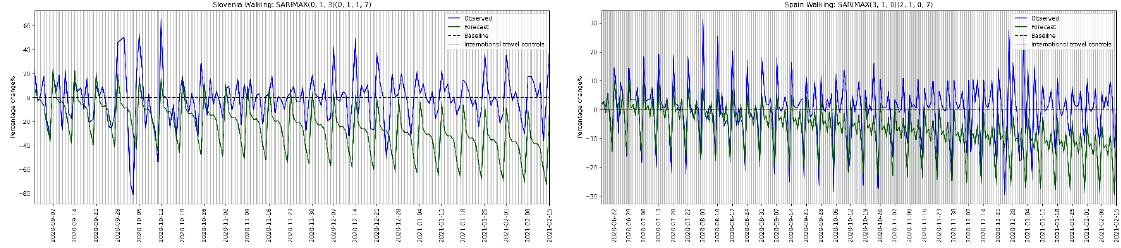
Figure 12. SARIMAX forecasts for walking in relation to International travel controls (a: Croatia, b: Poland, c: Portugal, d: Slovakia, e: Slovenia, f: Spain) The visual inspection of the difference between the observations and the forecasted values, namely the residuals, is important in order to ensure a no bias in the forecasting method (Hyndman and Athanasopoulos, 2018). In Figure 13, the diagnostics plot of the residuals from the SARIMAX model for walking in relation to school closing in Austria is presented as an example, with a standardized over time residuals plot, a histogram plus estimated density of standardized residuals, along with the normal density plotted, a normal Q-Q plot, with the normal reference line and a Correlogram (Seabold and Perktold, 2010). The top left plot shows no significant correlation in the residuals series, while the mean value is close to zero. In addition, this time plot does not display any obvious seasonality and appear to be white noise. The histogram on the top left plot suggests normal residuals, as the orange line follows closely the normal distribution. A normal indication of the residuals is also provided from the qq- plot, in which the residual distribution follows the linear trend of the samples taken from a standard normal distribution. The autocorrelation (i.e. correlogram) plot on the bottom right exhibits that the time series residuals have low correlation with lagged versions of itself. Similar insights are presented from the diagnostics plots of all SARIMAX models.